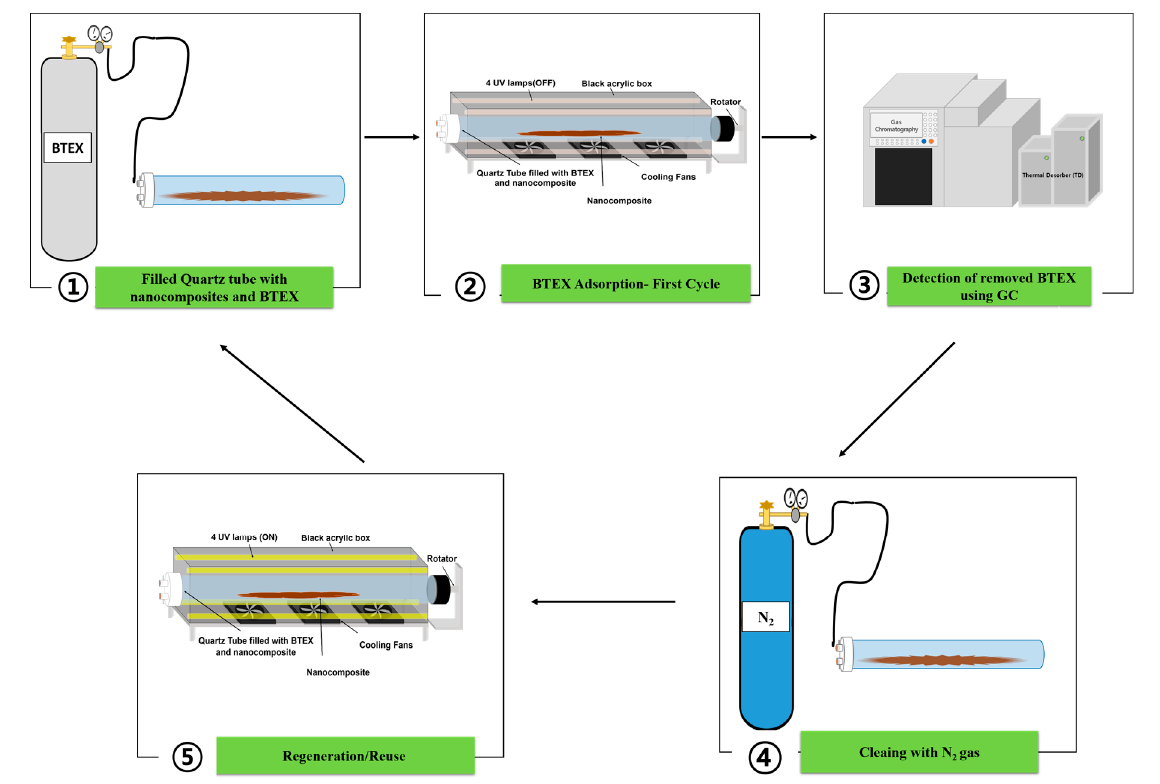
Figure 1. Schematic illustration of the experimental methodology.